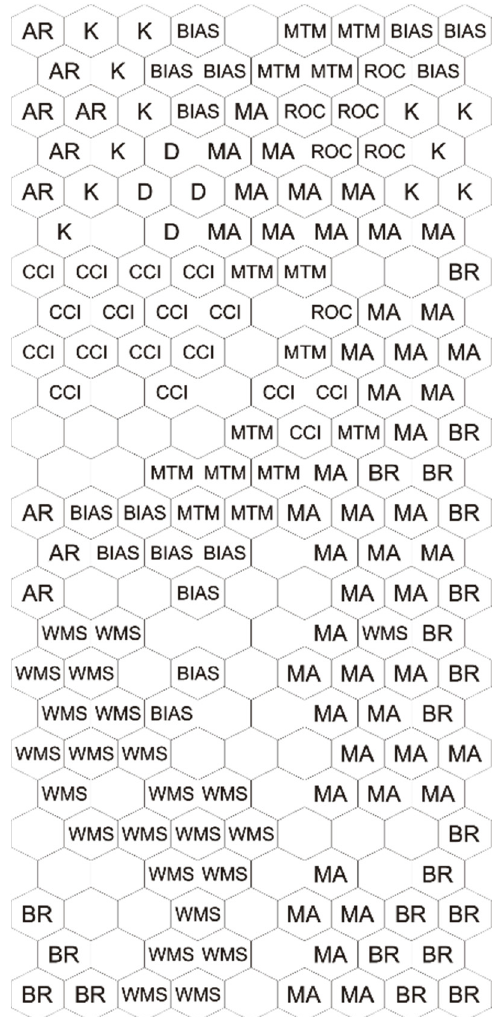
Figure 5. Visual identification of clusters after the network training. This figure is a reproduction of the results on the bottom right of Figure 4. The identification of clusters corresponds to the indexes defined in Equations (4) to (16).